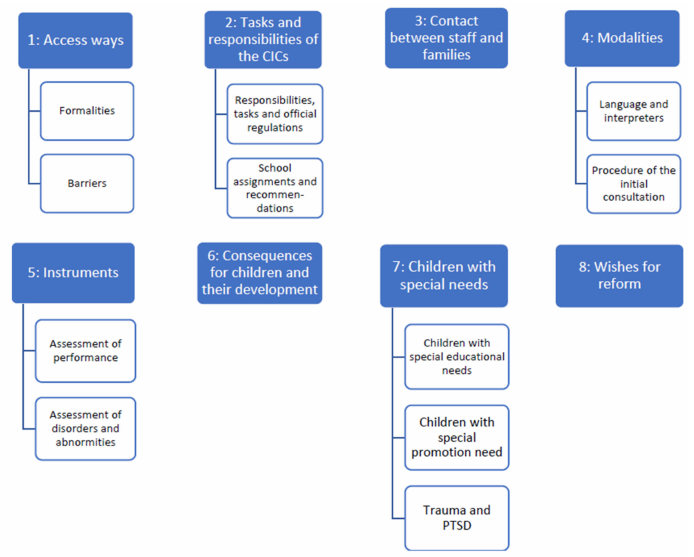
Figure 3. Category system developed using the qualitative content